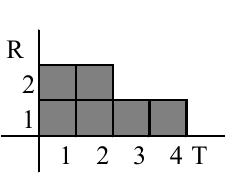
Fig. 3. activity under category C (